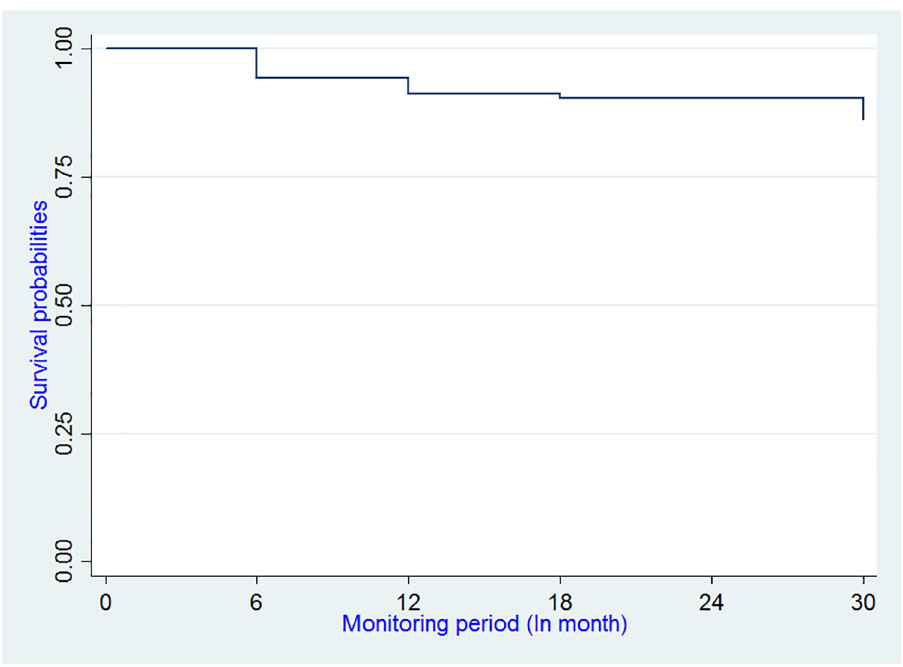
Fig 3. Kaplan-Meier estimate of the survival function of HIV seroconversion among MSM, Benin 2018.